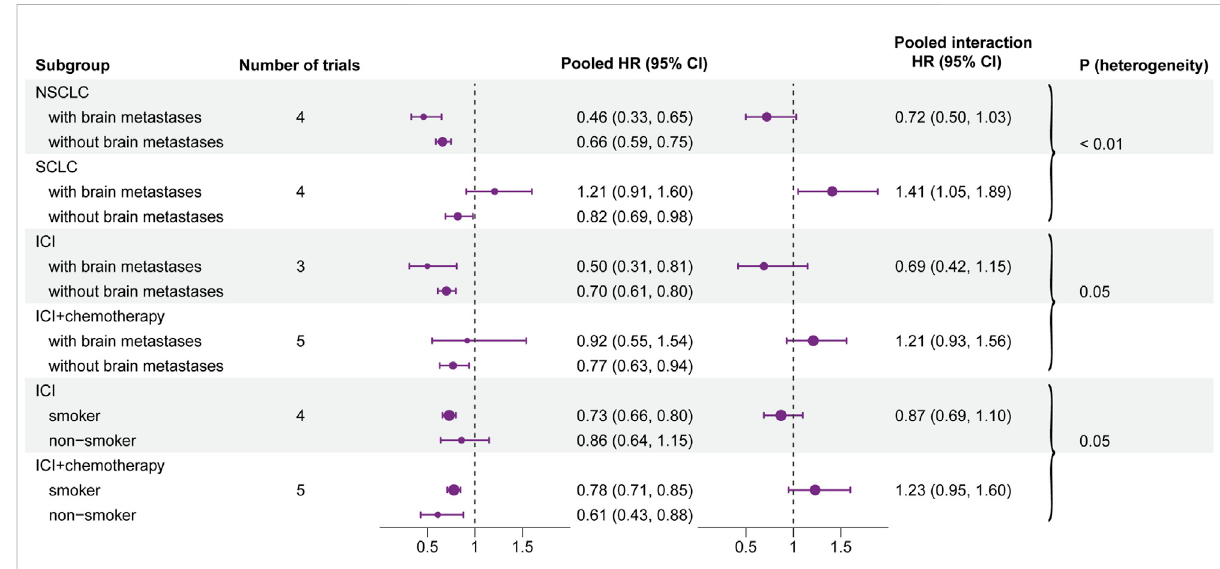
FIGURE 4 Forestplotofhazardratiosforoverallsurvivalaccordingtothepositiveresultsofeachsubgroup.Leftforestplot:hazardratiosofoverallsurvival for subgroups and baseline characteristics. Right forest plot: interaction between immunotherapy ef fi cacy and baseline characteristics in different subgroups (i.e., type of therapy and type of